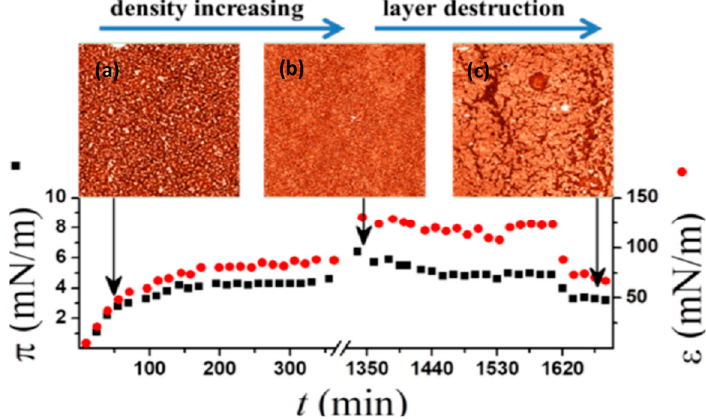
Figure 14. Upper side. AFM images of different samples of fullerenol C60(OH)x (x = 30 ± 2) film: ( a ) 70 min after the surface formation; ( b ) 16 h after the surface formation without oscillations; ( c ) after continuous oscillations for 75 min; lower side. The kinetic dependencies of the dynamic surface elasticity are shown with continuous barrier oscillations and various concentrations of fullerenol C60(OH) X (x = 30 ± 2), taken from [126].